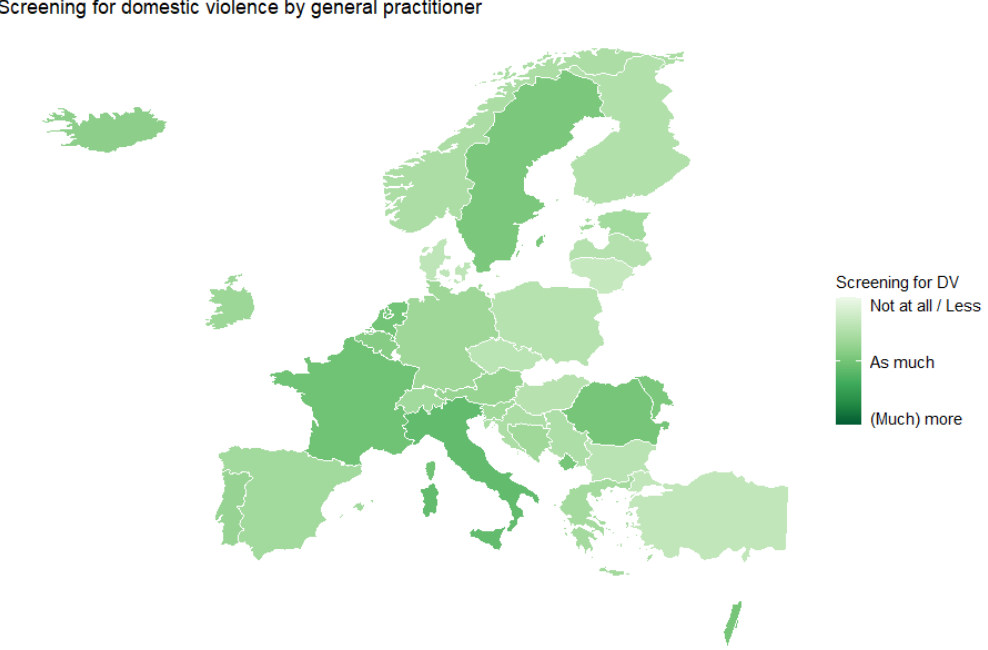
Figure 2. Screening for DV by the GP or GP trainee during the COVID-19 pandemic, average score by country.